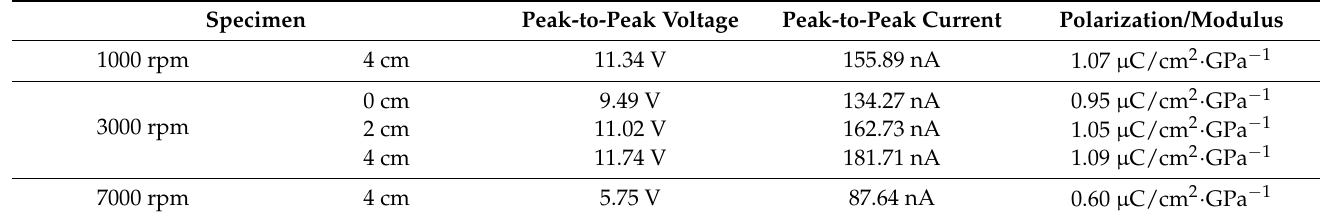
Table 3. A comparison of piezoelectric output with the remnant polarization over Young’s modulus for P(VDF-TrFE) films obtained at various distances under different rotational speeds.